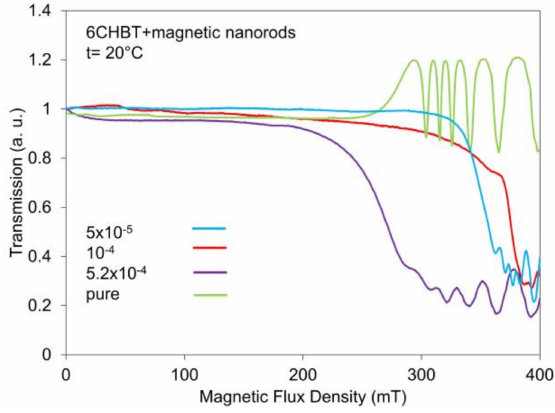
Figure 4. Magneto-optical characteristics of 6CHBT liquid crystal doped with nanorods of di ff erent concentration, including pure